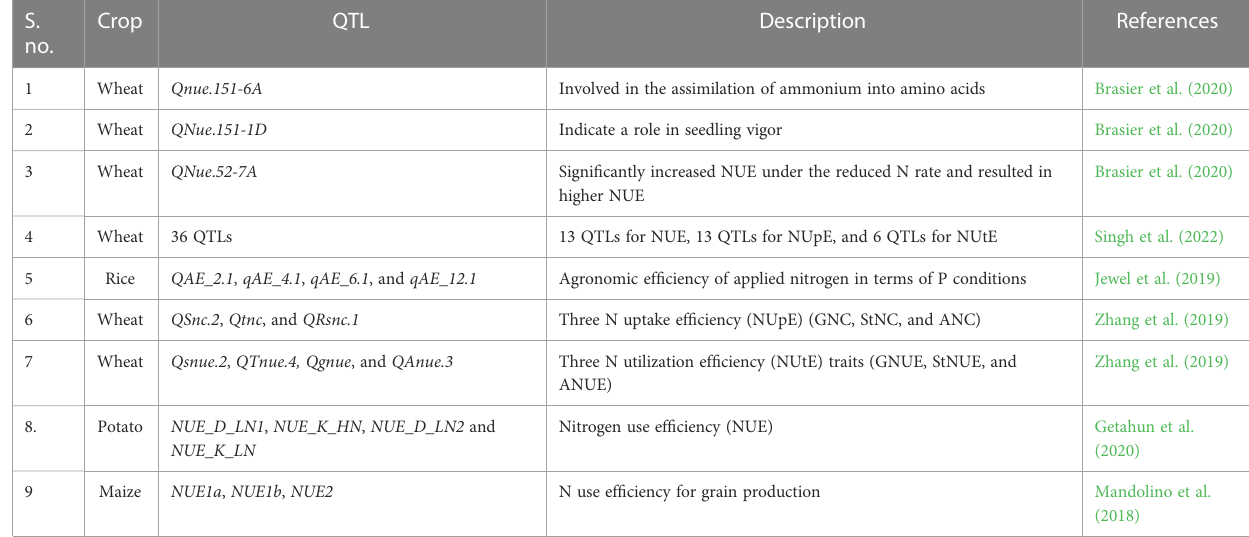
TABLE 4 QTLs identi fi ed in various crops related to